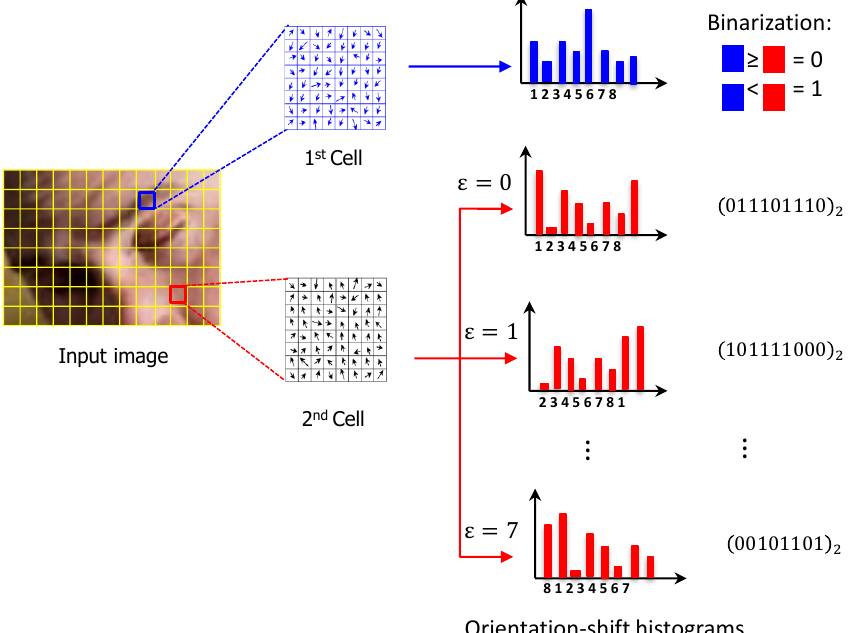
Figure 5. Extraction process of histogram of oriented gradient (HOG) features.